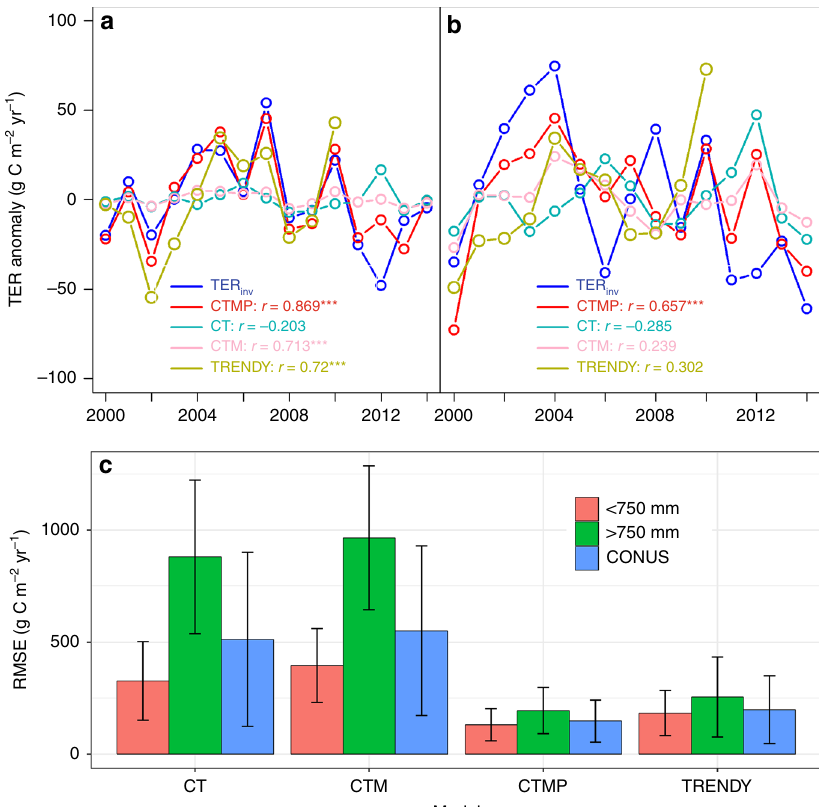
Fig. 3 Ecosystem respiration was best explained by models that included production and soil carbon content, temperature and precipitation. Ecosystem respiration empirical model results showed that TER (total ecosystem respiration) inverted (TER inv ) from gridded observations of MODIS GPP (gross primary production) and inversion NEE (net ecosystem carbon exchange) was best explained by the TER CTMP model despite its larger number of degrees of freedom (AIC CTMP = 163.6, AIC CT = 242.8, and AIC CTM = 251.6, AIC stands for Akaike information criterion) that included GPP and soil carbon content, temperature and precipitation as predictors, especially in the humid region of CONUS. a , b are annual TER anomaly for regions below and above 750 mm yr − 1 , respectively. The r values in a and b showed the temporal correlation between TER inv anomaly and modeled TER anomaly. Symbols *,**,*** in a and b indicate the signi fi cant level at 0.1, 0.05, and 0.001 levels. c is the spatially averaged RMSE between TER obs and modeled TER (error bars show one standard deviation). CT: soil carbon/temperature model, CTM: soil carbon/temperature/water availability model, CTMP: soil